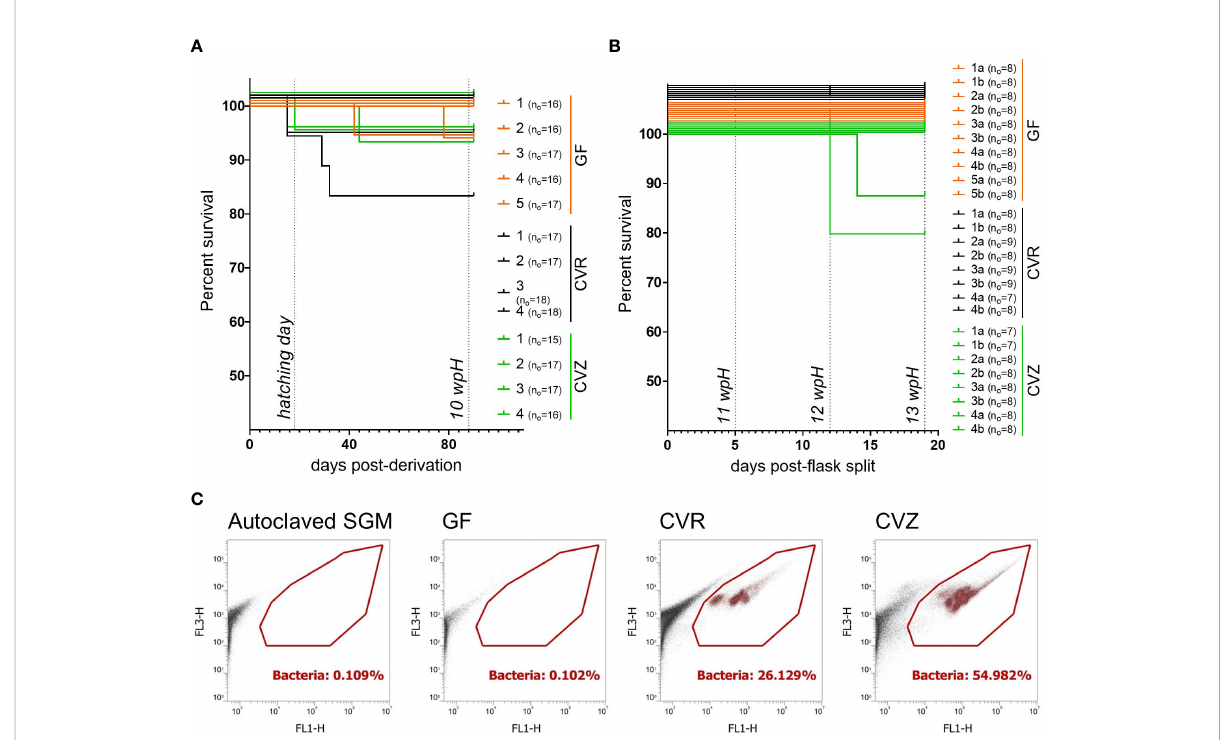
FIGURE 2 Gnotobiotic rearing of Atlantic salmon fry during the yolk sac stage (A) Survival curves from replicate fl asks housing GF, CVR, and CVZ yolk sac fry until approximate 10 wpH. Days post-derivation and weeks post-hatching (wpH) are indicated on the x-axis. (B) Survival curves from replicate fl asks housing GF, CVR, and CVZ yolk sac fry after splitting fl asks and until 13 wpH. Days post-split and weeks post-hatching (wpH) are indicated on the x-axis. Survival curves were signi fi cantly different (p = 0.0129, Mantel-Cox and Gehan-Breslow-Wilcoxon tests). In (A, B) survival curves were compared using Mantel-Cox, Gehan-Breslow-Wilcoxon, and Log-rank tests. For visualization purposes only, survival curves were nudged on the y axis to separate overlapping curves. Initial number of fry (n o ) per fl ask is indicated. (C) Representative plots from fl ow cytometry-based bacterial cell counts in SGM from GF, CVR, and CVZ fl asks at 10 wpH. Each GF fl ask was analyzed at 10 wpH (before splitting fl asks) and at 12 wpH. For the gating strategy for samples stained with SYBR ™ Green I, Red/Orange fl uorescence (FL3-H) versus green fl uorescence (FL1-H) were plotted to distinguish the background from the bacteria (gated). The bacterial cell counts per fl ask and timepoint are shown in Supplementary Table